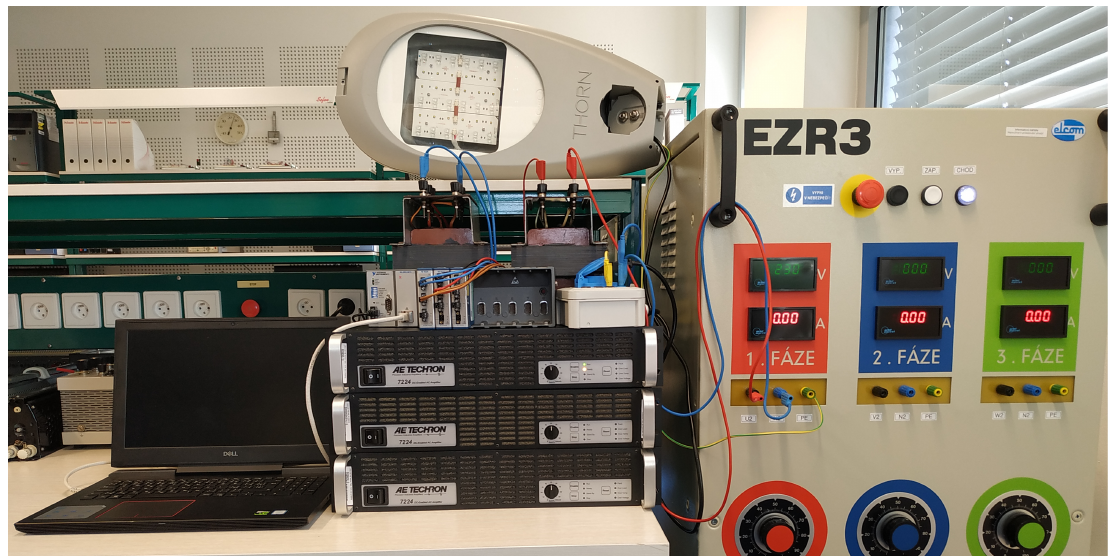
Figure 21. Realized laboratory experiment with AE-Techron 7224 amplifiers used as inverters.